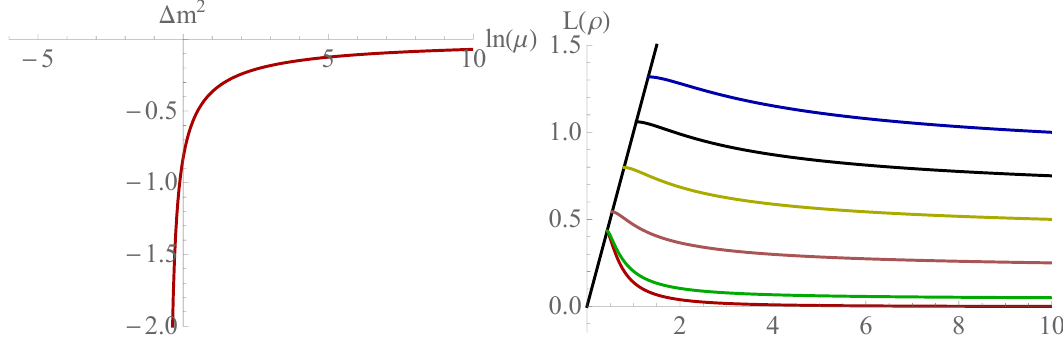
Figure 1. The N c = 3 , N f = 2 QCD model: on the left we display the running of the AdS scalar p mass ∆ m 2 against log RG scale (we use µ = ρ 2 + L 2 in the holographic model). On the right we show the vacuum solution for | X | = L ( ρ ) against ρ . The 45 ◦ line is where we apply the on mass shell IR boundary condition in eq. (2.10). The L ( ρ ) with a massless UV quark has L IR = 0 . 43 . The quark masses from top to bottom are 1, 0.75, 0.5, 0.25, 0.05, 0. Here units are set by α ( ρ = 1) = 0 . 65